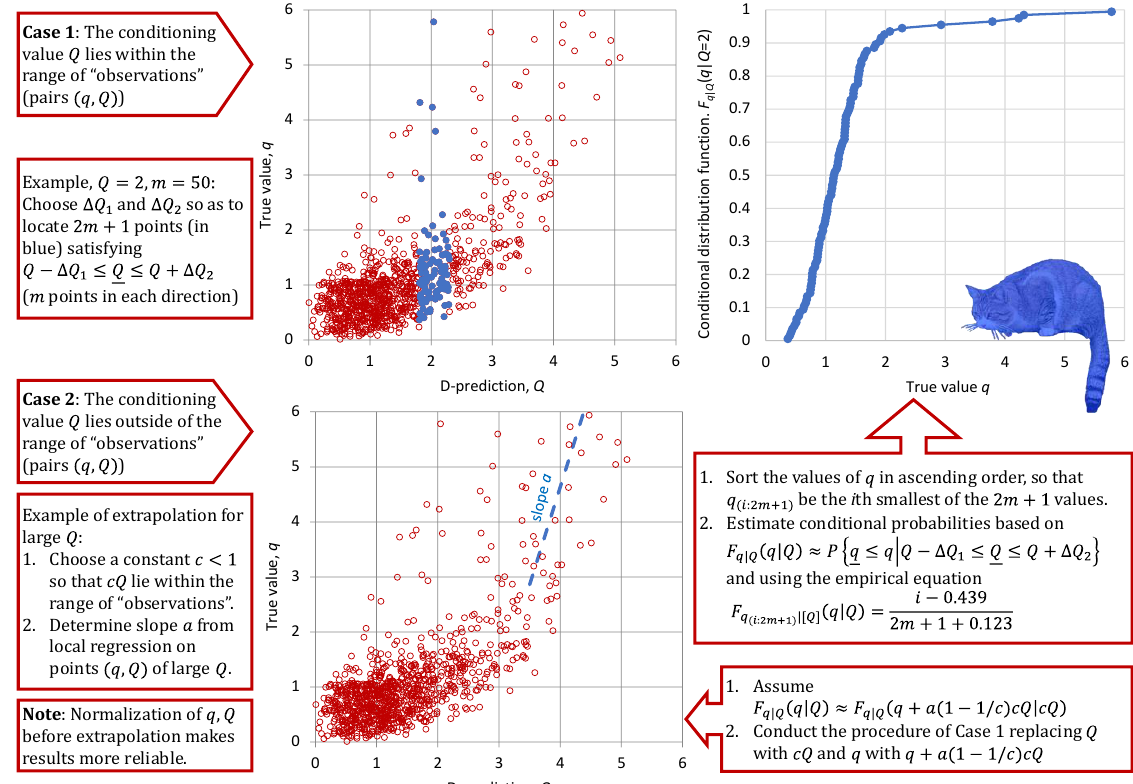
Figure 1. Schematic representation of the expanded Bluecat method.